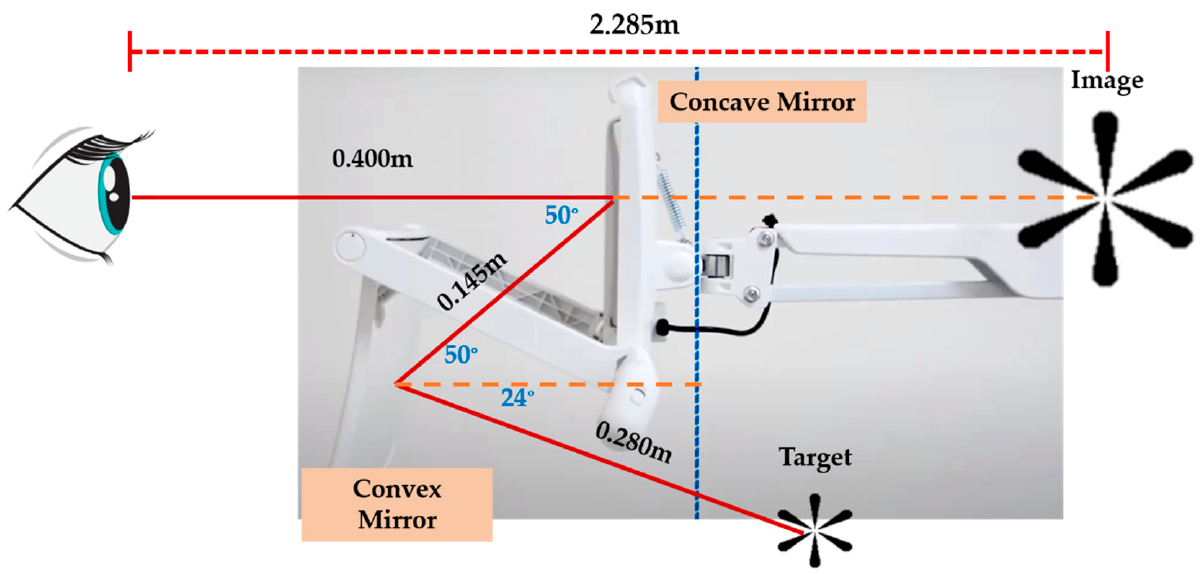
Figure 1. A double-mirror system (DMS) for the application of extending the viewing distance.